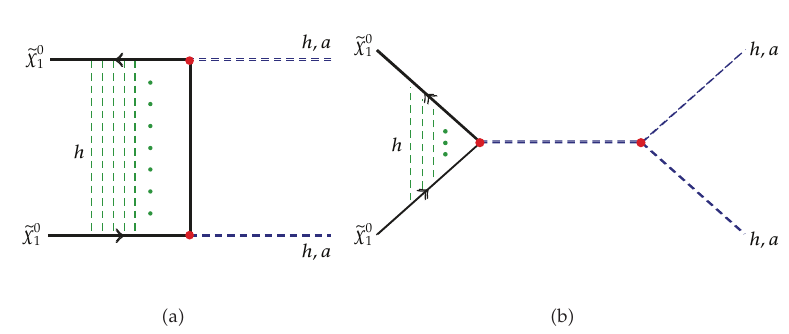
Figure 9: Feynman diagrams for singlino dark matter annihilation where Sommerfeld enhancement is induced by exchanging h (cid:2) taken from (cid:5) 45 (cid:6)(cid:3) .